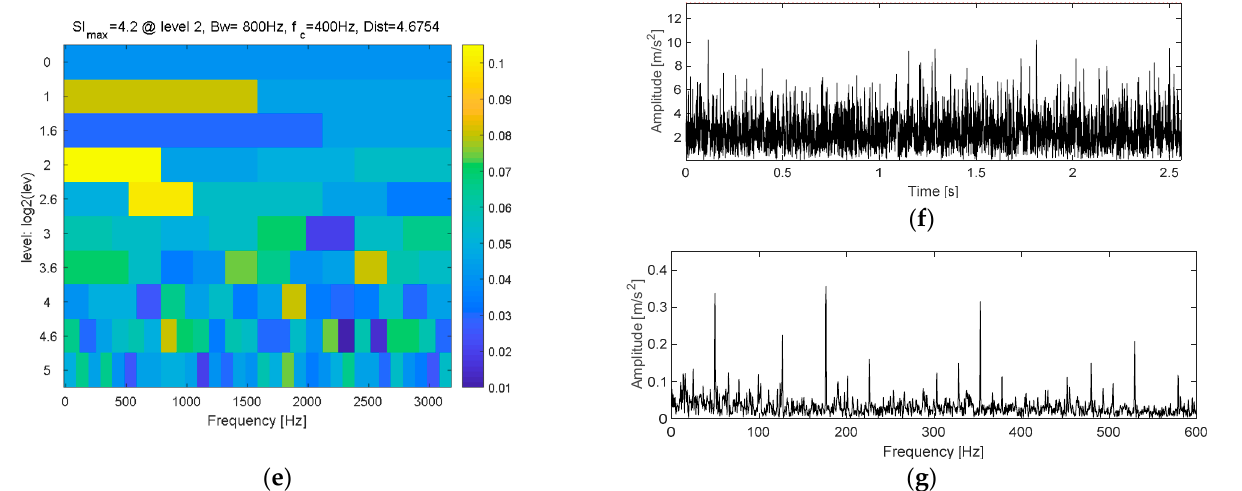
Figure 10. Engineering verification of the proposed method. ( a ) The original vibration signal of the engineering bearing. ( b ) Envelope spectral of the signal shown in ( a ). ( c ) The filtered signal of the signal shown in ( a ) using the proposed AMF. ( d ) Envelope spectral of the signal shown in ( c ). ( e ) Analysis result of the signal shown in ( c ) using the proposed FBS method. ( f ) Envelope of the filtered signal of the signal shown in ( c ) using the proposed FBS method. ( g ) FFT of the signal shown in ( f